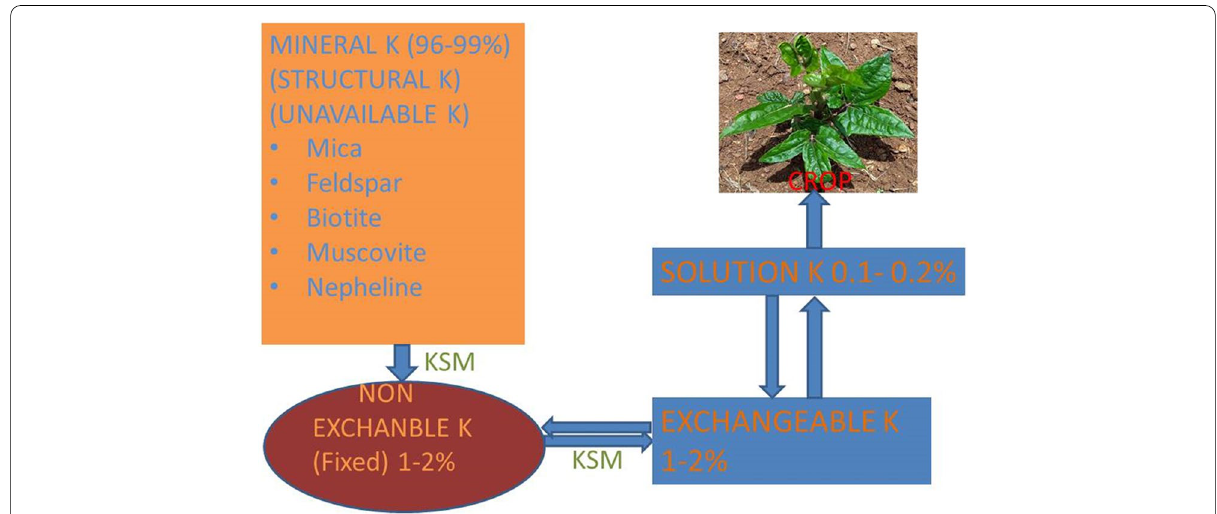
Fig. 1 The various forms of potassium (K) and circulation in the